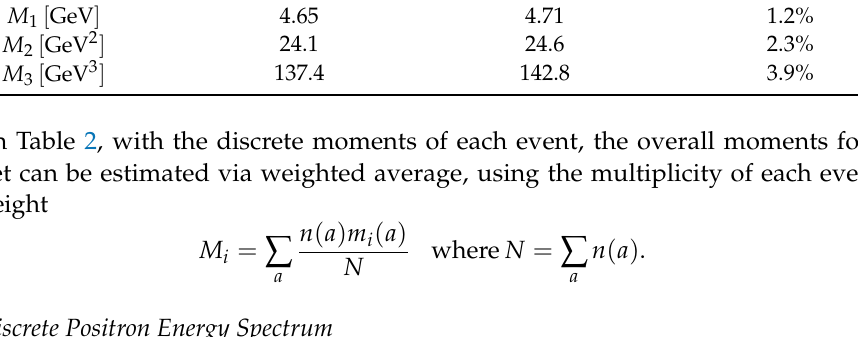
Figure 2. CNN outputs of the multiplicity and the first and second central moments for each event. The events are ordered according to the true (MC) number of positrons n true . The left and right frames refer to the smaller (<200) and larger ( ≥ 200) multiplicities. The predictions of the CNN agree with the values of the MC data. These results are used to evaluate the average moments of the energy distributions displayed in Table 2. Table 2. Moments of the energy distribution of the test set of the ρ = 3 µm source, summing over all events. The true values are determined from the MC data, and the reconstructed values arise from the CNN evaluation of the ECAL analysis of individual events, as described above. Moments True